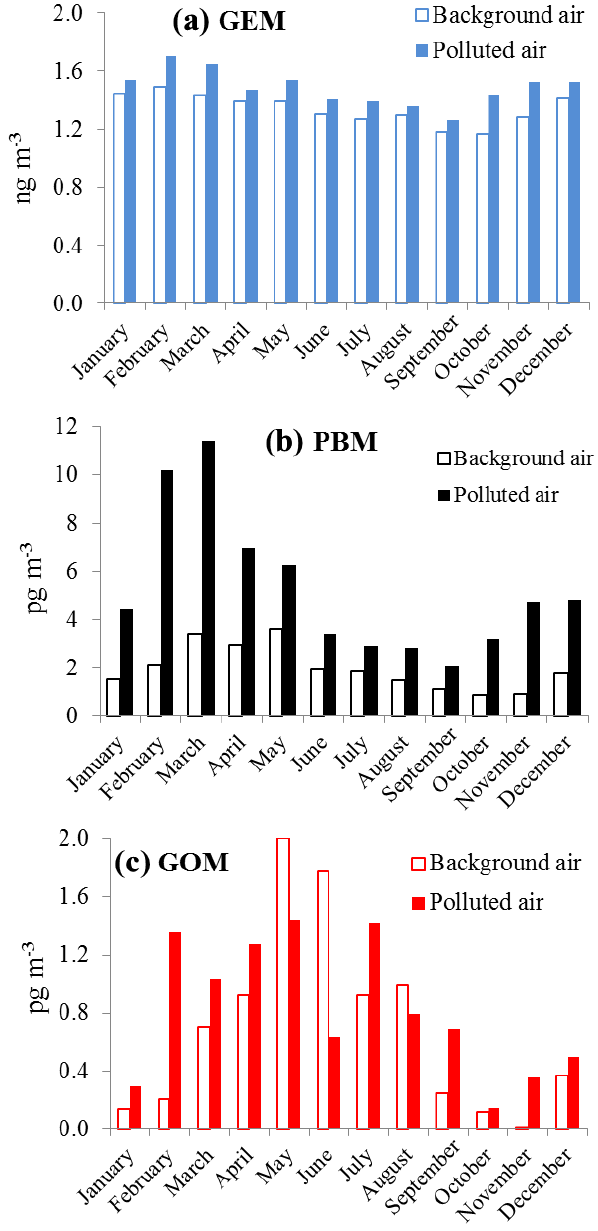
Figure 4. Average mercury air concentrations as a function of month and origin of air masses at the Råö measurement site. The values represent monthly averages of all data from the measure- ments made from 15 May 2012 to 29 April